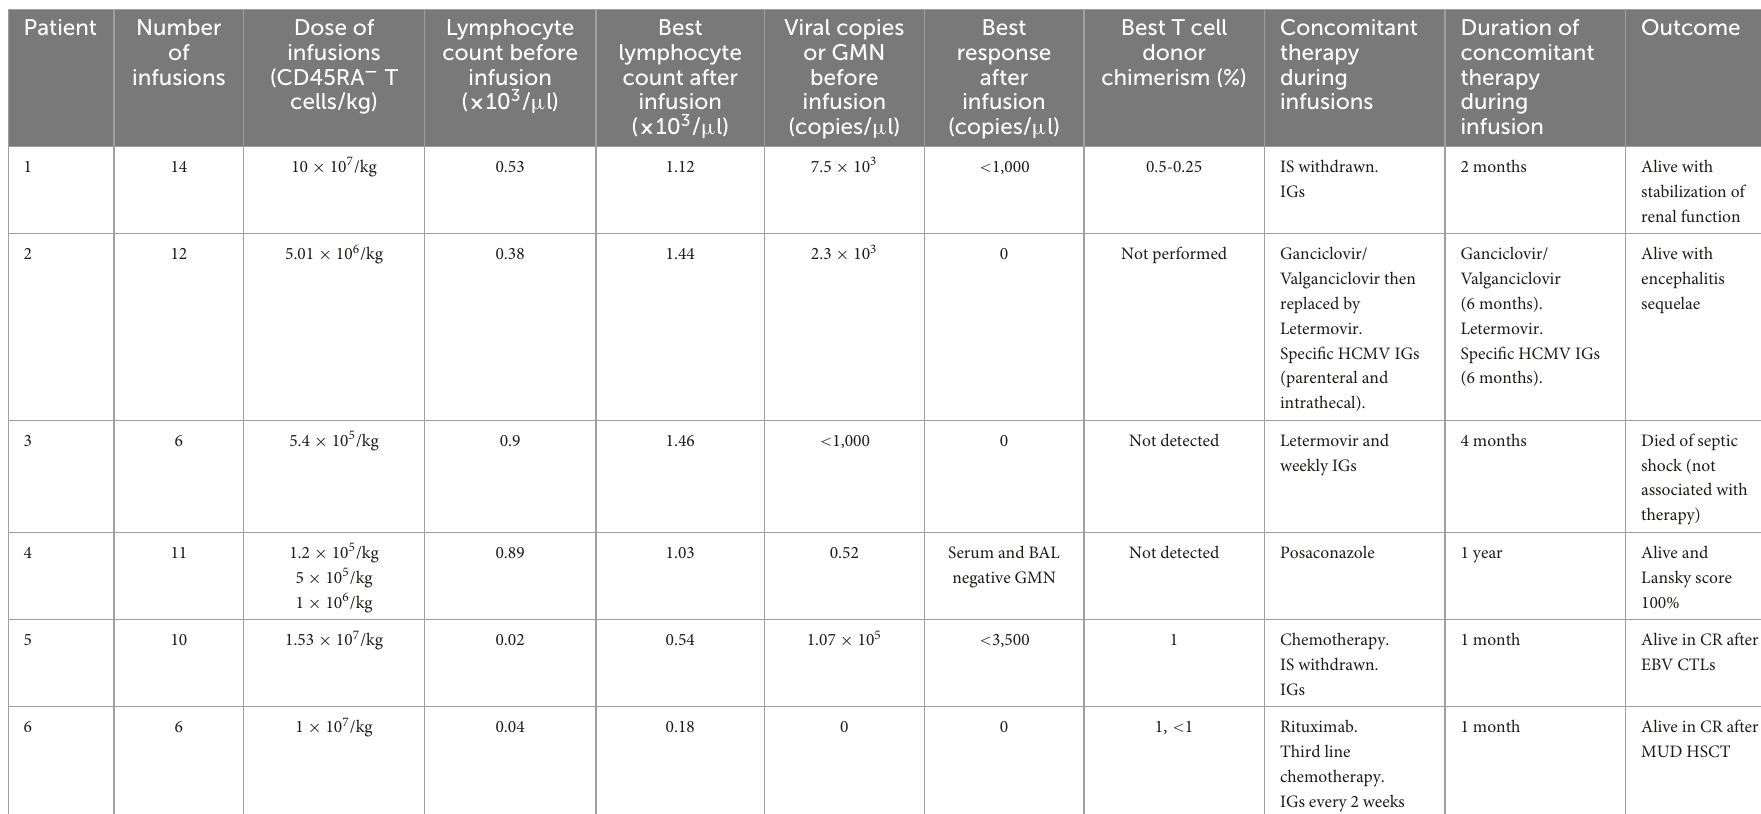
TABLE 3 Infusion characteristics, response and outcomes after therapy with familial CD45RA − T cells containing pathogen-specific memory T cells (BAL, Broncho-alveolar lavage; GMN,